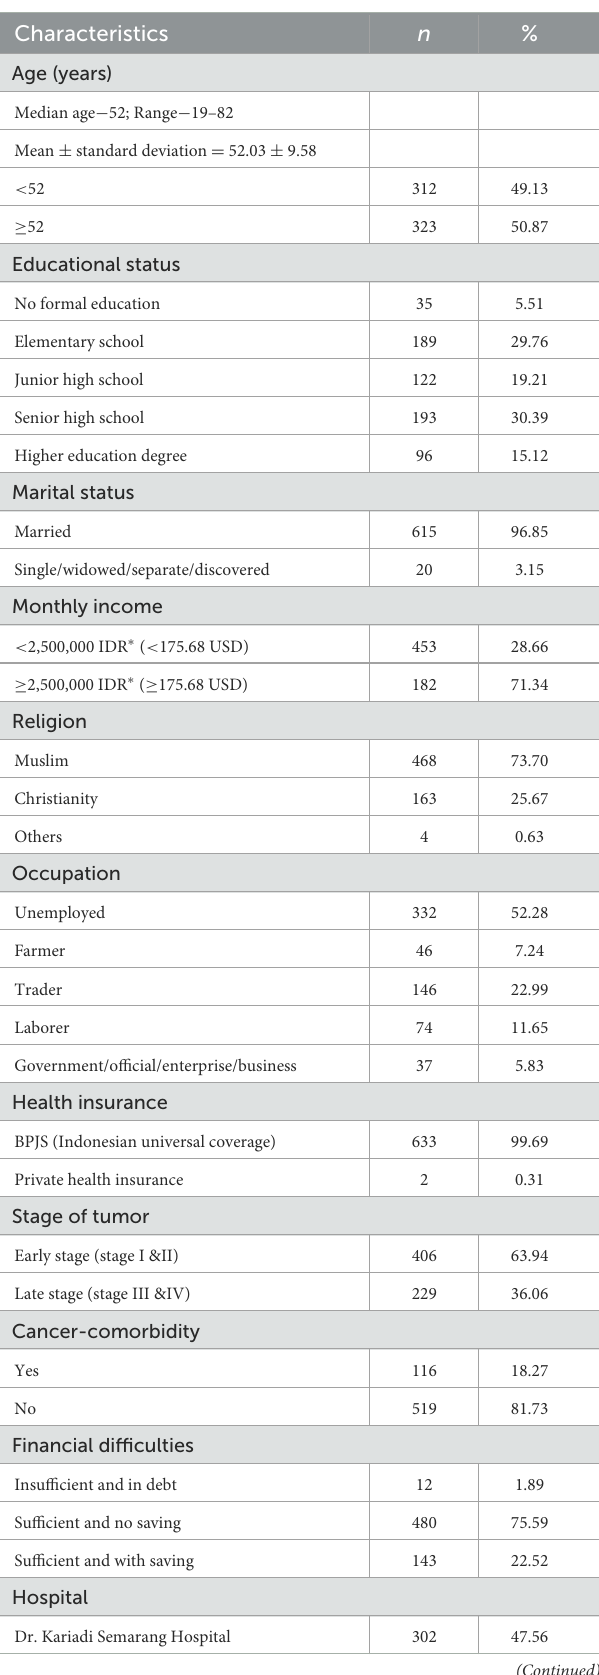
TABLE 1 Participant characteristics ( N =